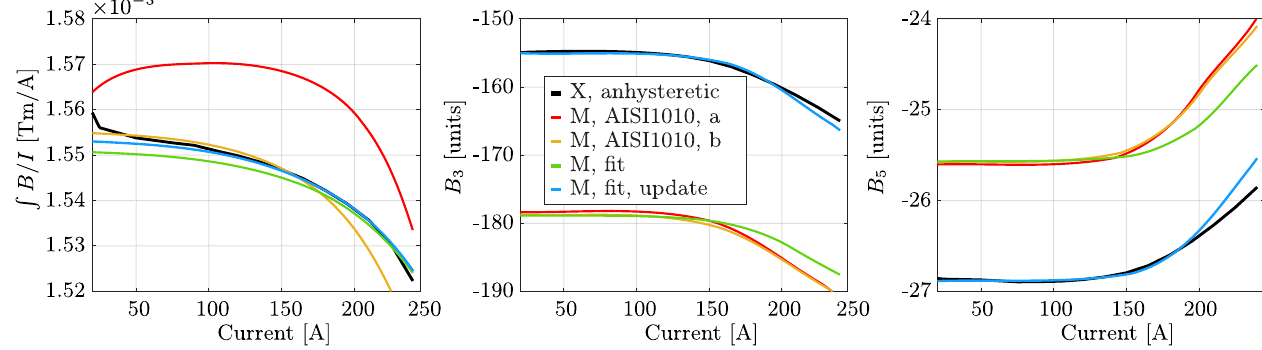
(right).FIG. 5. Integral quantities as a function of the excitation current of the MDX magnet. The letter X denotes the experimental quantity (measurements) and M the different iterations of the